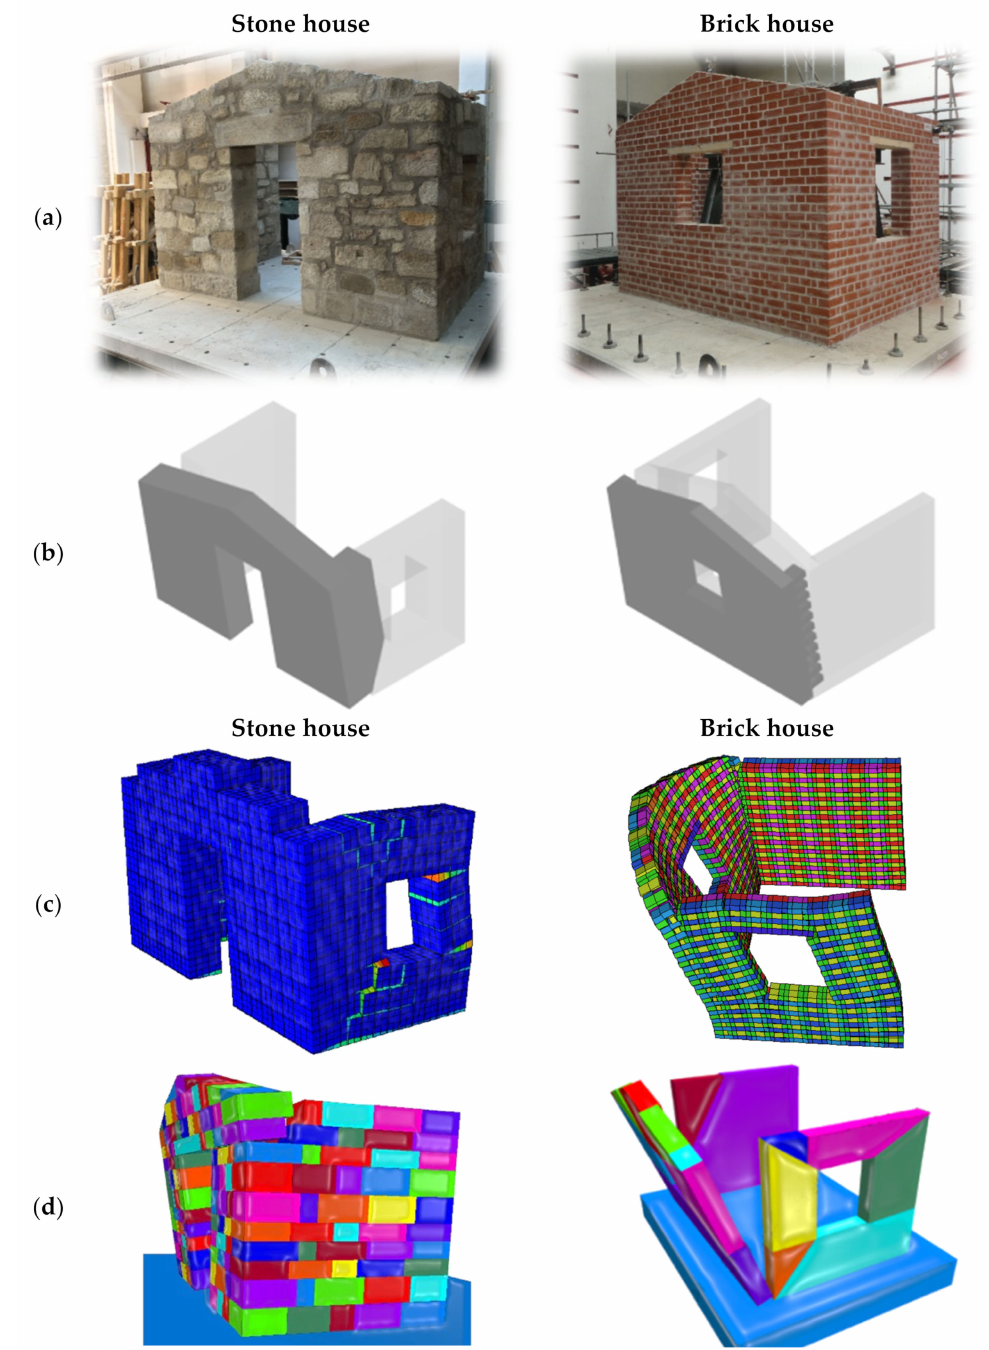
Figure 11. Examples of models adopted for the blind predictions of the ( a ) tested masonry structures: ( b ) models with rigid macro-blocks; ( c ) FEM models and ( d ) DEM